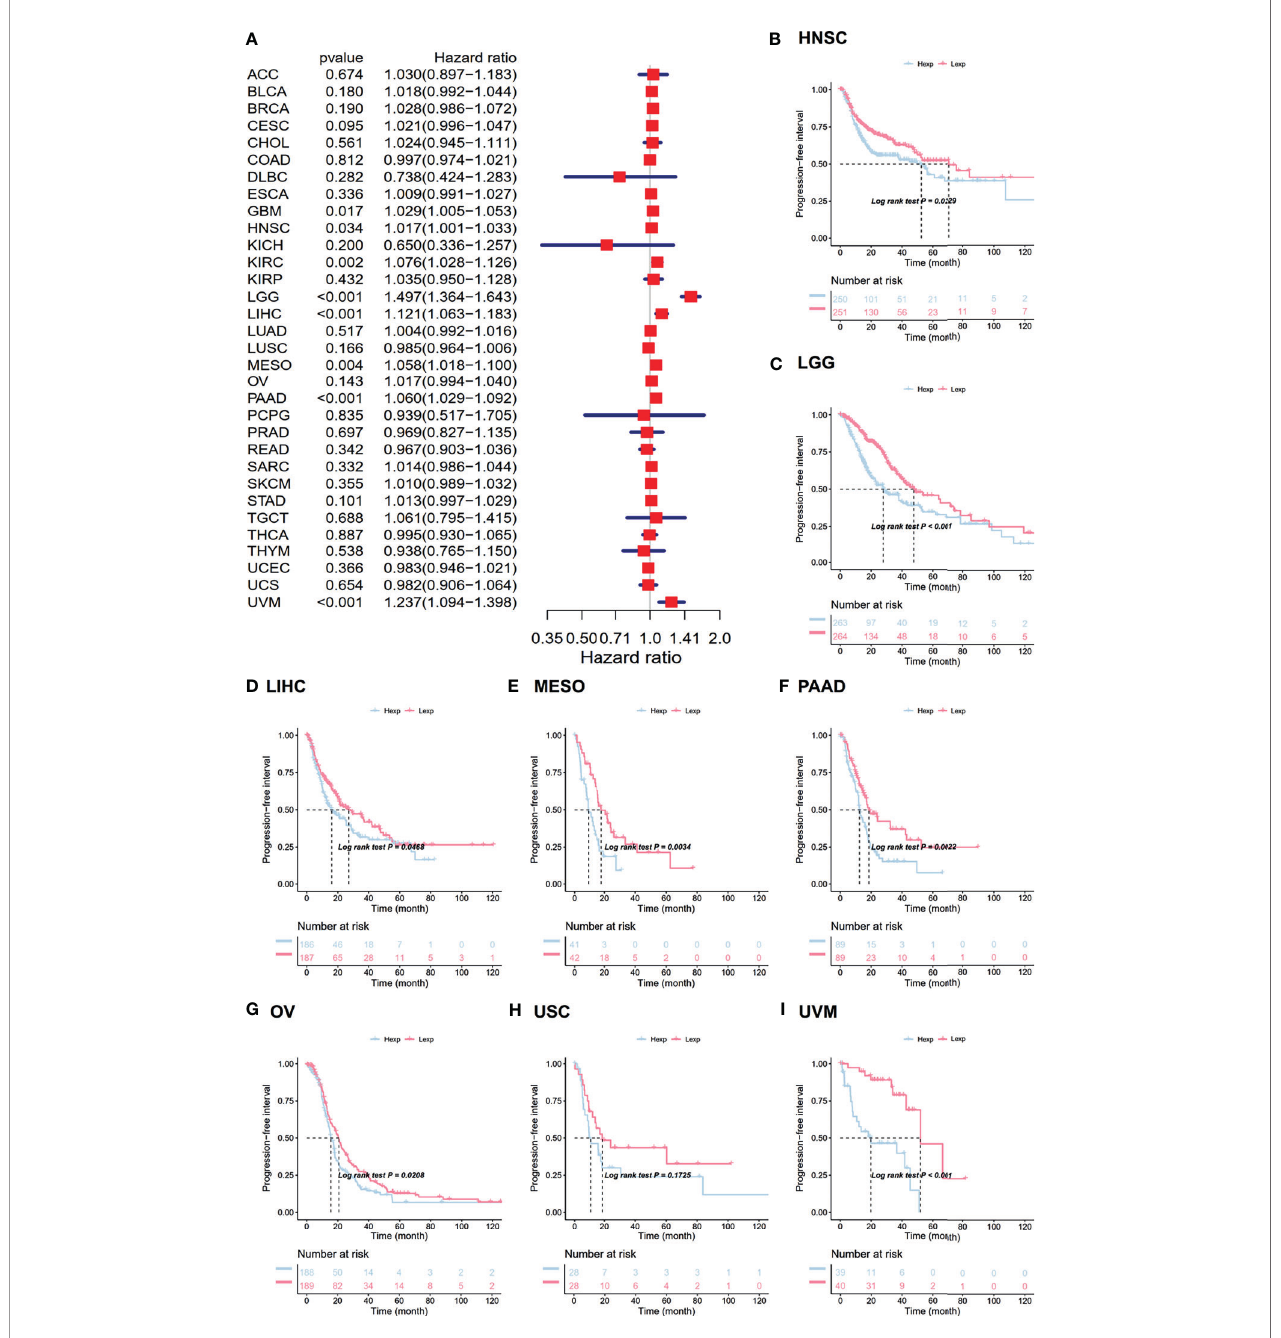
FIGURE 3 | Relevance for ANXA2P2 expression levels to progression-free interval in months. (A) Forest map related to PFI of pan-carcinoma. Kaplan-Meier analysis of the correlation between ANXA2P2 expression and PFI in (B) HNSC, (C) LGG, (D) LIHC, (E) MESO, (F) PAAD, (G) OV, (H) USC, and (I)